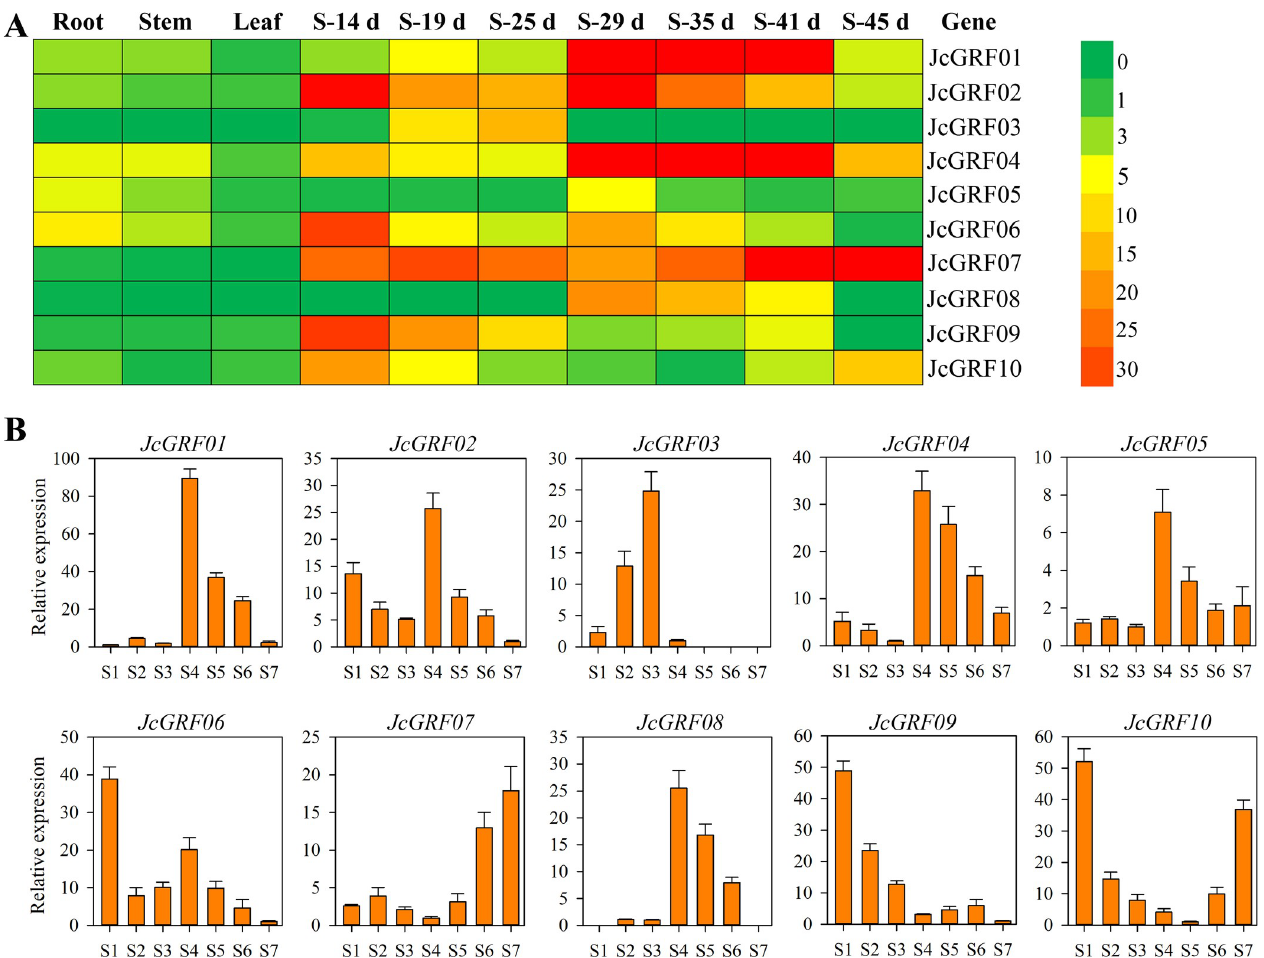
Fig 6. Transcription abundance of JcGRF genes in various tissues of Jatropha curcas based on RNA-seq and qRT-PCR data. (A) Patterns of expression of each JcGRF gene in Jatropha curcas roots, stem cortex, leaves, and seeds of 14 (S1), 19 (S2), 25 (S3), 29 (S4), 35 (S5), 41 (S6) and 45 (S7) based on RNA-seq, with a colored scale indicating expression levels shown on the right. NA means not available. (B) The expression of JcGRF genes in seeds of 14 (S1), 19 (S2), 25 (S3), 29 (S4), 35 (S5), 41 (S6) and 45 (S7) days after pollination was detected by qRT-PCR. Values represent means of n = 3 ± SD from three biological repeats.